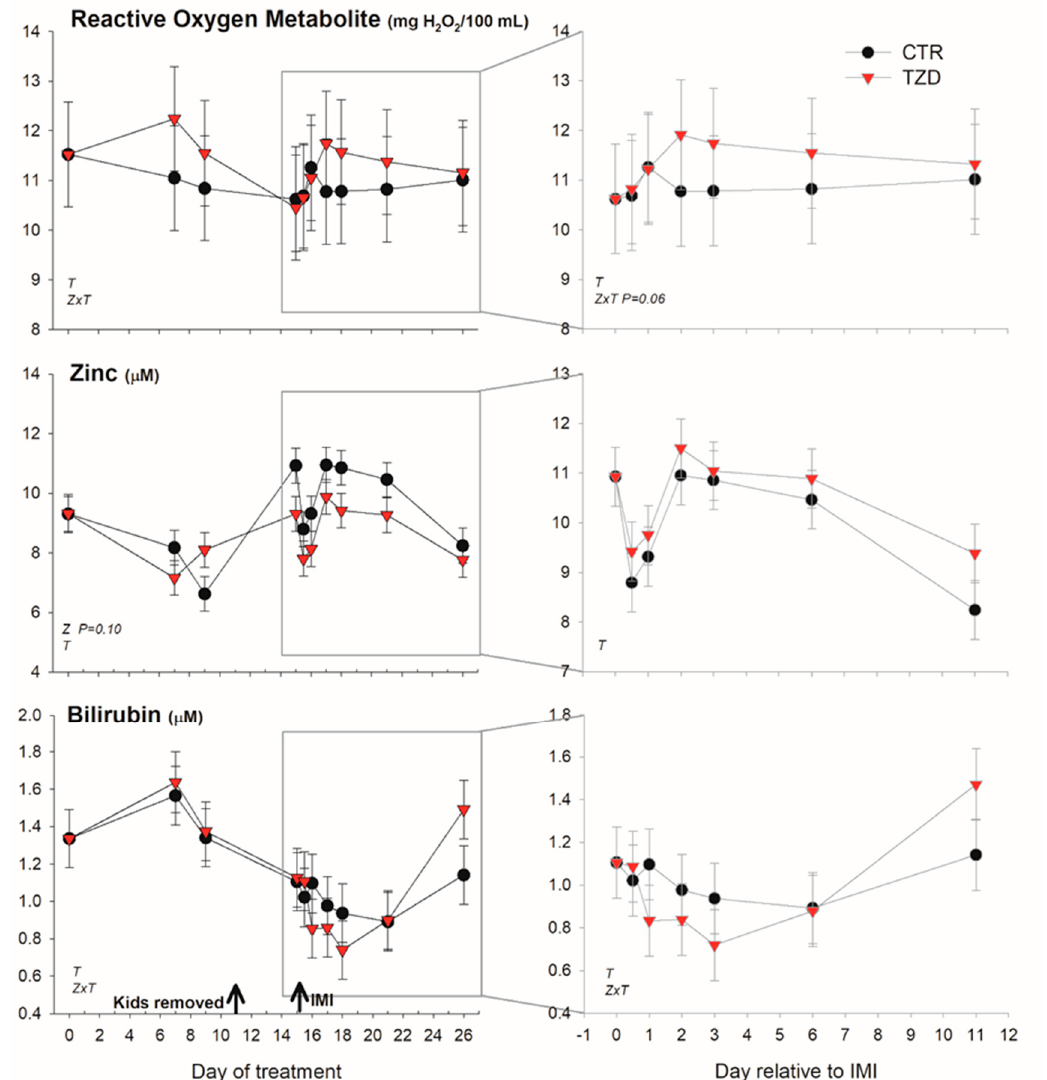
Figure 5. Effect of a daily injection of 2,4-thiazolidinedione (TZD) and saline (CTR) in Saanen dairy goats plus intramammary infusion in the right half of the mammary gland with Strep. uberis (IMI) while the left half of the mammary was left untouched (control) on reactive oxygen species, zinc, and bilirubin (as an index of liver function). The left quadrants report the pattern of each parameter during the whole study. Arrows indicate time of kid removal and IMI. The quadrants on the right denote the pattern of the same parameters after IMI (with correction with baseline before IMI, see Materials and Methods). Overall statistical significance ( p ≤ 0.05) is indicated in the plot as follows: T = time effect; M = IMI effect; Z = effect of 2,4-thiazolidinedione injection.